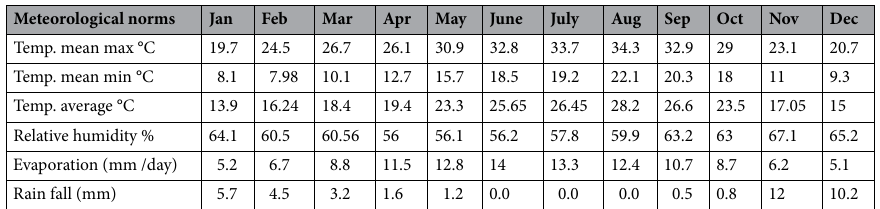
Table 1. Average climatological data of Wadi El Natrune (1986–2016). The climatological data are collected from Wadi El Natrun station from (1986) to (2016).